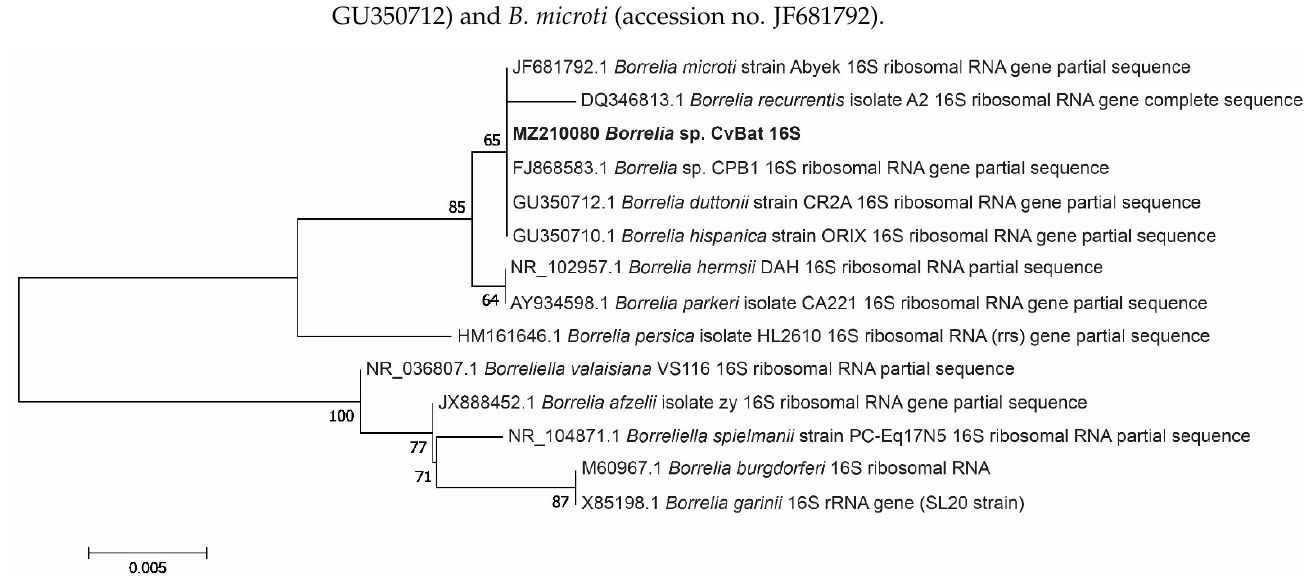
Figure 3. Phylogenetic tree based on flaB gene sequences of Borrelia species. Sequences detected in our study (‘‘MZ217187 Borrelia sp. CvBat flaB’’, n = 6) are highlighted in bold.